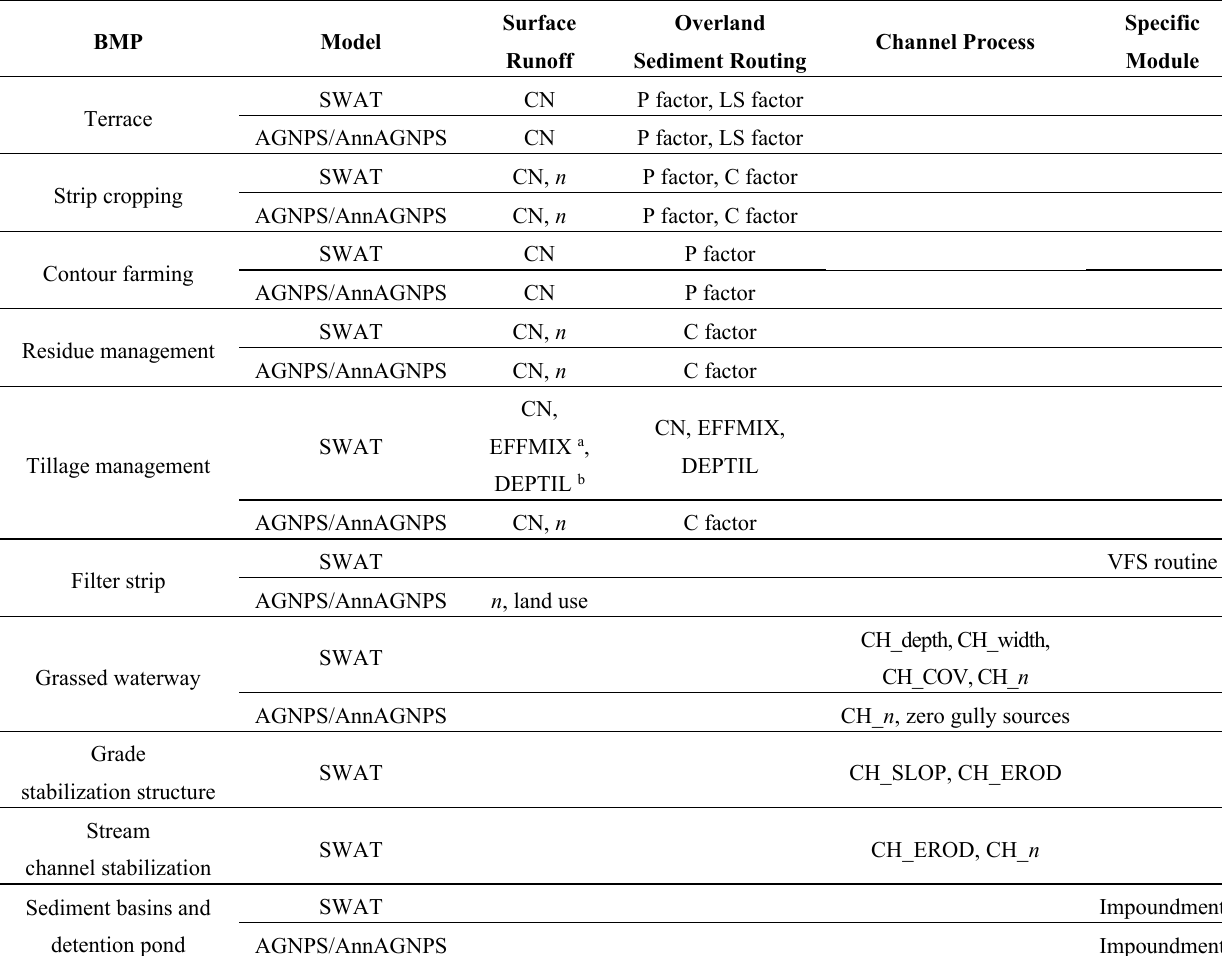
Table 3. Key parameters and processes of watershed models (SWAT, AGNPS/AnnAGNPS) for representing